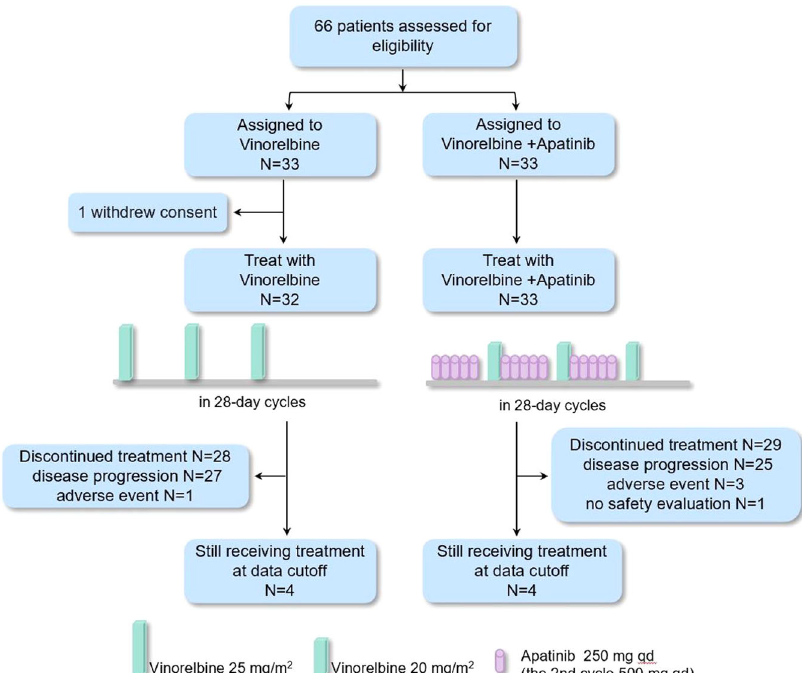
Fig. 1 Enrollment, randomization, and treatment. A total of 66 patients underwent randomization. 33 received apatinib plus vinorelbine treatment, 32 patients who were randomly assigned to vinorelbine monotherapy and 1 patient withdrew consent without receiving treatment. Vinorelbine monotherapy was administered as a once-per-week intravenous infusion of 25 mg/m 2 on days 1, 8, and 15 of each 28- day treatment cycle. In vinorelbine plus apatinib group, vinorelbine in administered intravenously at a dose of 20 mg/m 2 on day 7, 14, and 21 of each 28-day treatment cycle. Apatinib 250 mg was administered orally once daily at a fi xed time each day about 30 min after a meal, with treatment on days 1 to 5 of weeks 1, 2, and 3 within each 28-day cycle (if tolerable, the second cycle started with 500 mg per